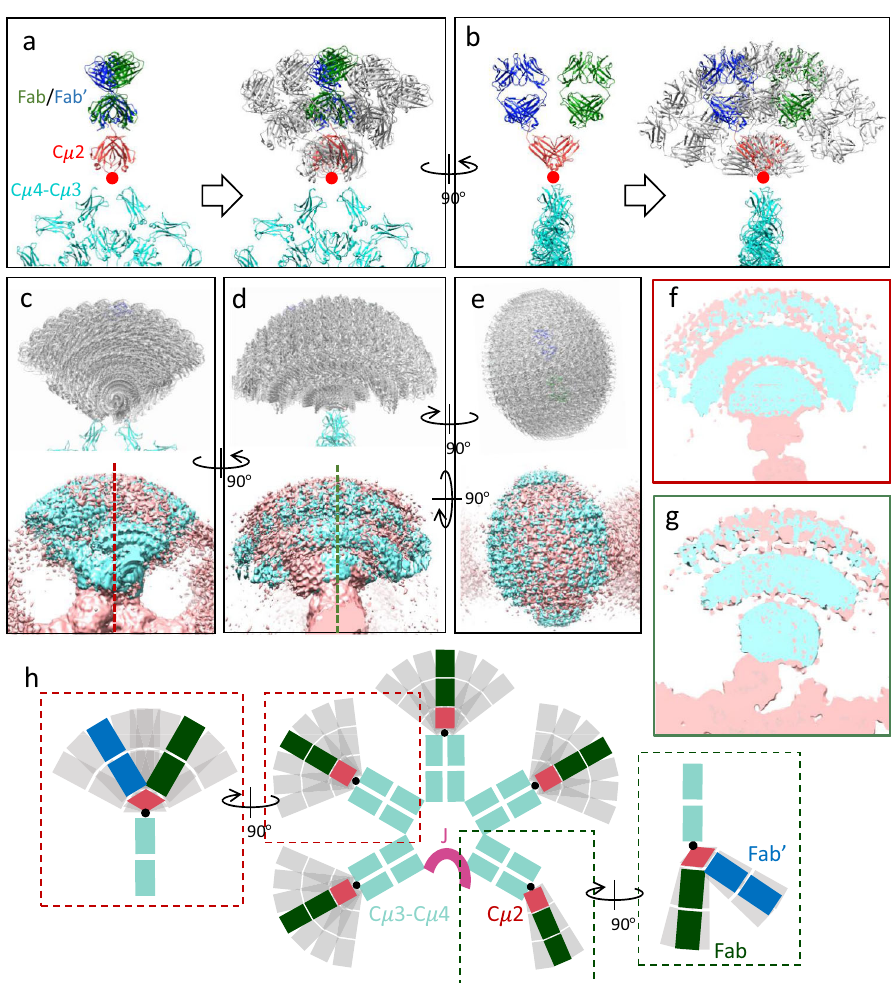
Fig.4|Model-basedinterpretationofthedensityofF(ab ’ ) 2 insubunit2-5based on the structure and fl exibility of F(ab ’ ) 2 in subunit 1. a F(ab ’ ) 2 model rigidly translatedfromsubunit1tosubunit4(leftpanel),andin-planepivotingofF(ab ’ ) 2 at the C μ 2/C μ 3 interface (right panel). b Left panel, side view of the left panel in ( a ). Rightpanel,out-of-planepivotingofF(ab ’ ) 2 atC μ 2/C μ 3interface.Reddotsin( a , b ) are the pivot point. c - e Upper panel, array of F(ab ’ ) 2 models with the in-plane and out-of-plane ranges of C μ 2 rotation at both ±50 (cid:3) with 10 (cid:3) interval. The actual in-